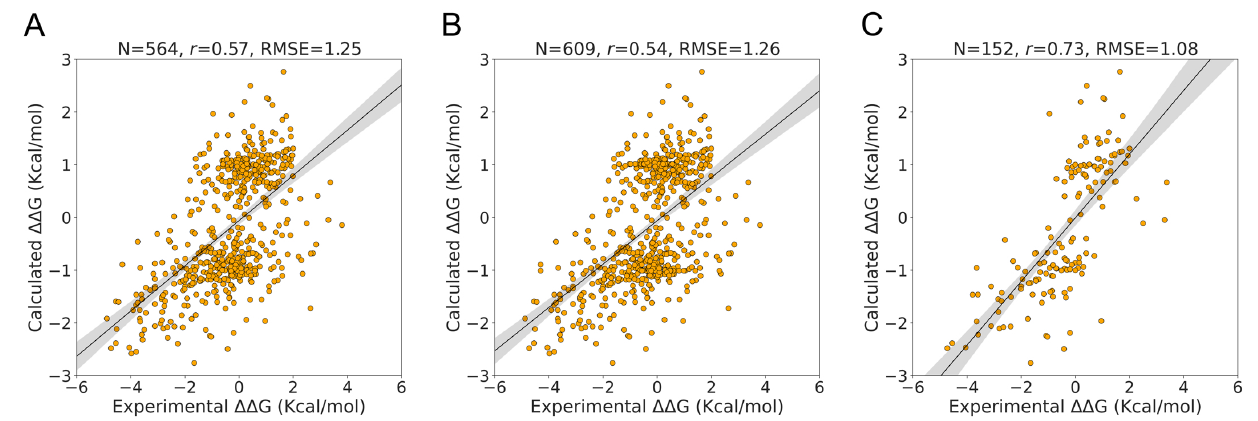
Figure 4. Performance on S611 dataset. Agreement between the experimental ∆∆ G and the PSP- GNM-calculated ∆∆ G is shown for ( A ) 564 mutants with a PSP-GNM-calculated ∆∆ G, ( B ) all 609 mu- tants, ( C ) 152 mutants with experimental temperatures ranging from 24 ◦ C to 26 ◦ C and pH ranging from 6.8 to 7.2. The regression line with the 95% confidence interval (shaded gray) is shown for all three cases. The optimal agreement is seen for ( C ), with a Pearson correlation of 0.73 and an RMSE of 1.08